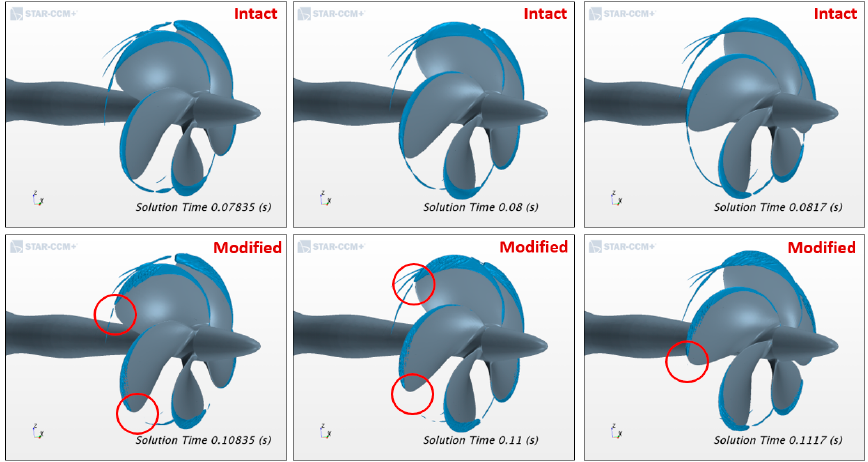
Figure 23. Pattern comparisons between intact and modified propellers for different blade positions. ( Top row : Intact propeller, Bottom row : Modified propeller).